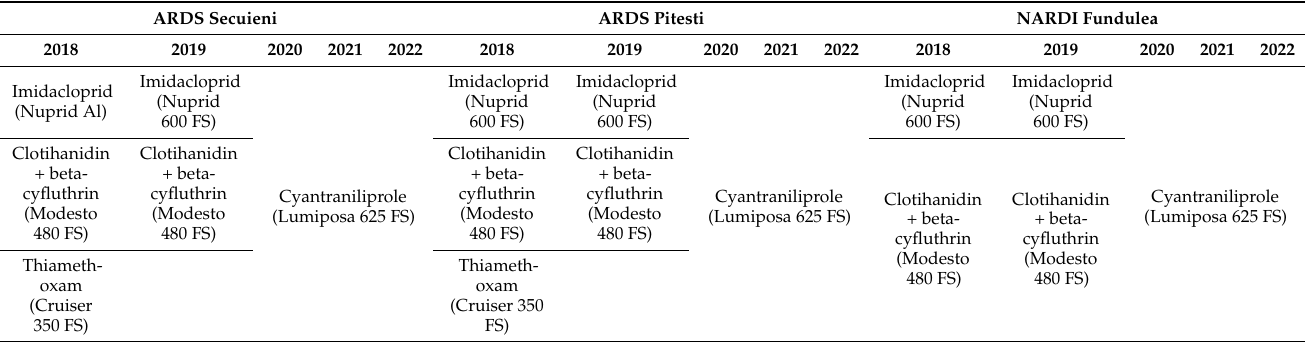
Table 1. Rapeseed experimental variants.